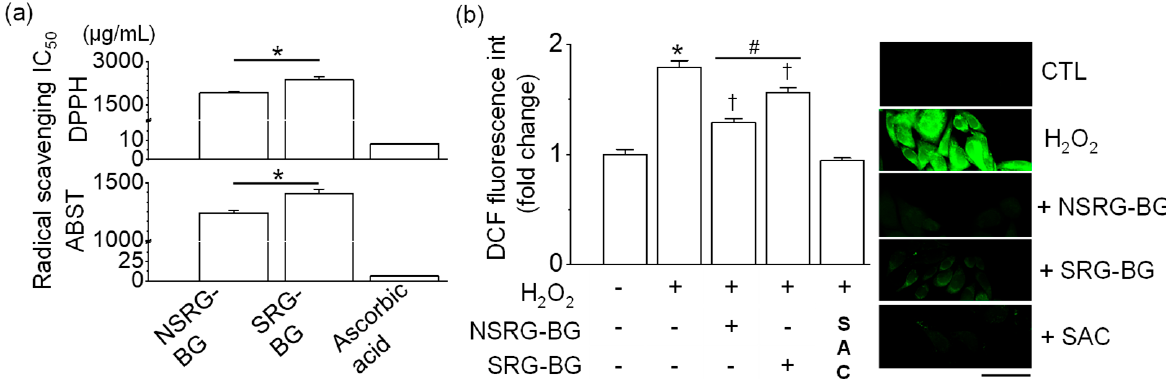
Figure 4. Antioxidant activity of BG made from SRG and NSRG. ( a ) DPPH and ABTS radical scavenging IC 50 . ( b ) H 2 O 2 -induced ROS generation. Chang cells were exposed to 500 μ M H 2 O 2 for 24 h after pretreatment with BG for 1 h. Green fluorescence represents ROS generation. NSRG-BG and SRG-BG represent BG made from NSRG and SRG, respectively. A BG extract mixture made from SRG harvested in 2015 and 2016 was used as SRG-BG. Ascorbic acid (2.5–10 μ g/mL) and SAC (1 mM) were used for a positive control for each experiment. Each bar represents mean ± SD of four independent experiments. * p < 0.05 compared to each corresponding control. † p < 0.05 compared to H 2 O 2 treatment. # p < 0.05, NSRG-BG vs. SRG-BG. NSRG-BG and SRG-BG indicate BG made from NSRG and SRG, respectively.